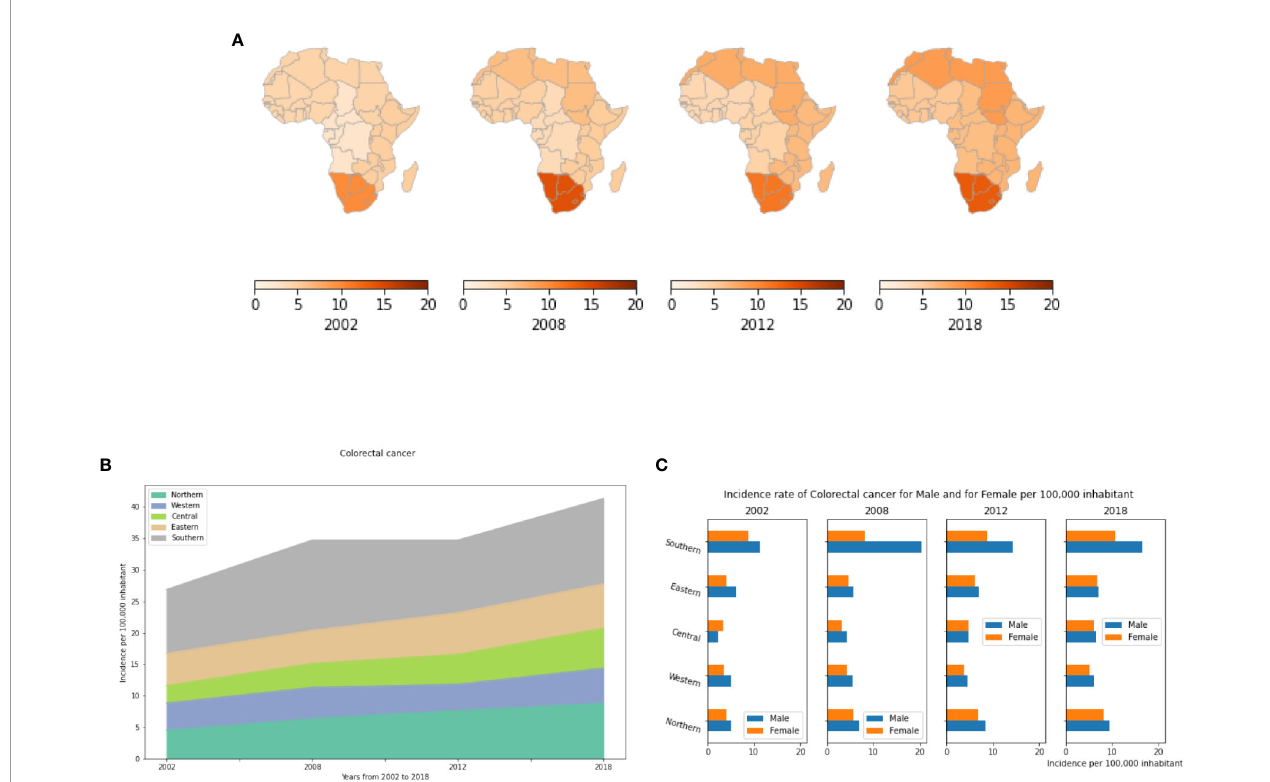
FIGURE 6 | Colorectal cancer incidence rates per year, by African region and by gender. (A) Colorectal cancer incidence rates per 100,000 inhabitant in different African regions. (B) Dynamics of incidence rates from 2002 to 2018. (C) Colorectal cancer Incidence rate by gender in